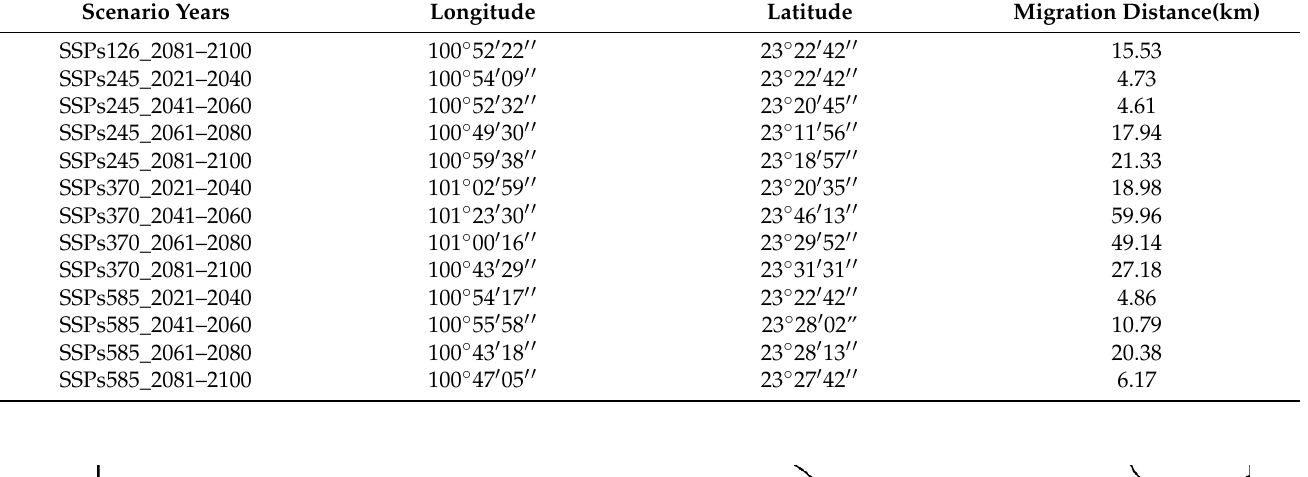
Table 6. Predicted current distribution of the core distributional shifts under different climate scenarios/years for Arabica coffee .